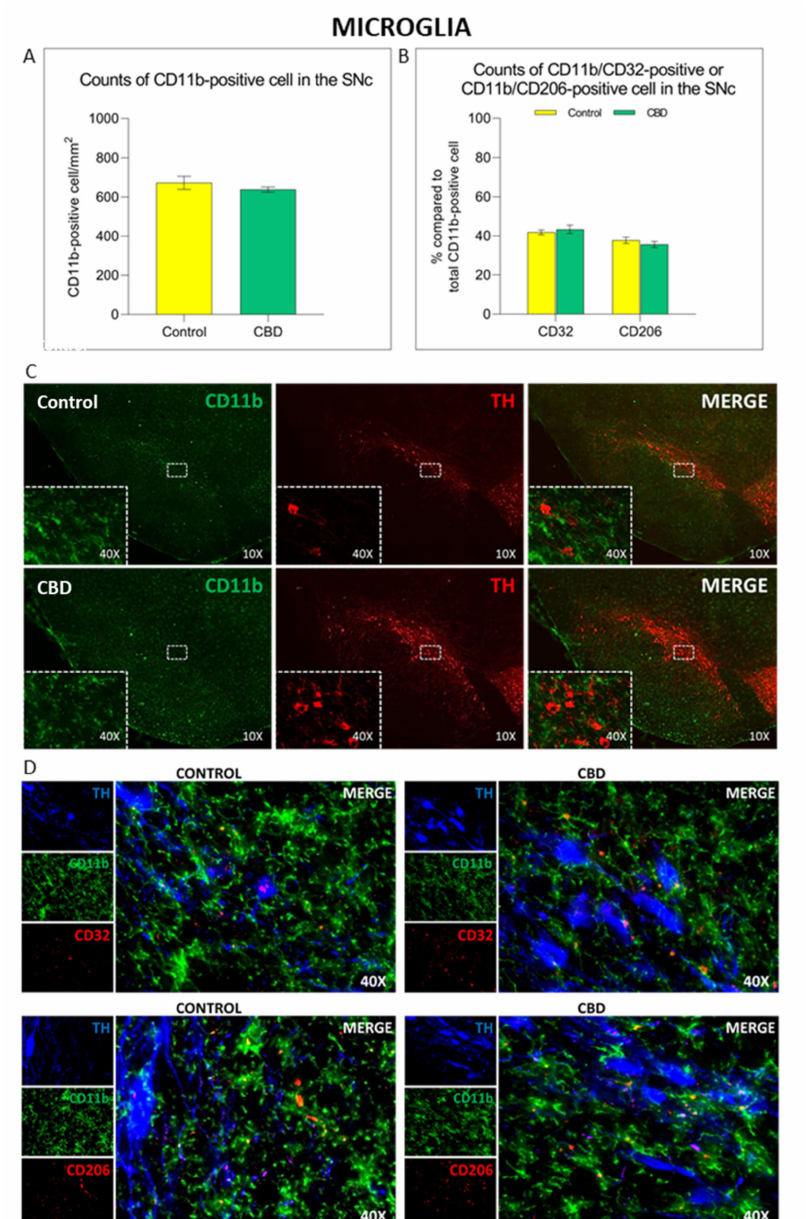
Figure 3. Immunomodulatory effect of chronic treatment with CBD on microglia activation and polarization in the SNc. Com-parison of ( A ) CD11b + cell density and ( B ) microglia polarization state in the SNc in both experimental groups. ( C , D ) Representative images of the microglia activation and polarization in the SNc in both experimental groups. The results are expressed as mean ± SEM. N = 6 to 8 in each